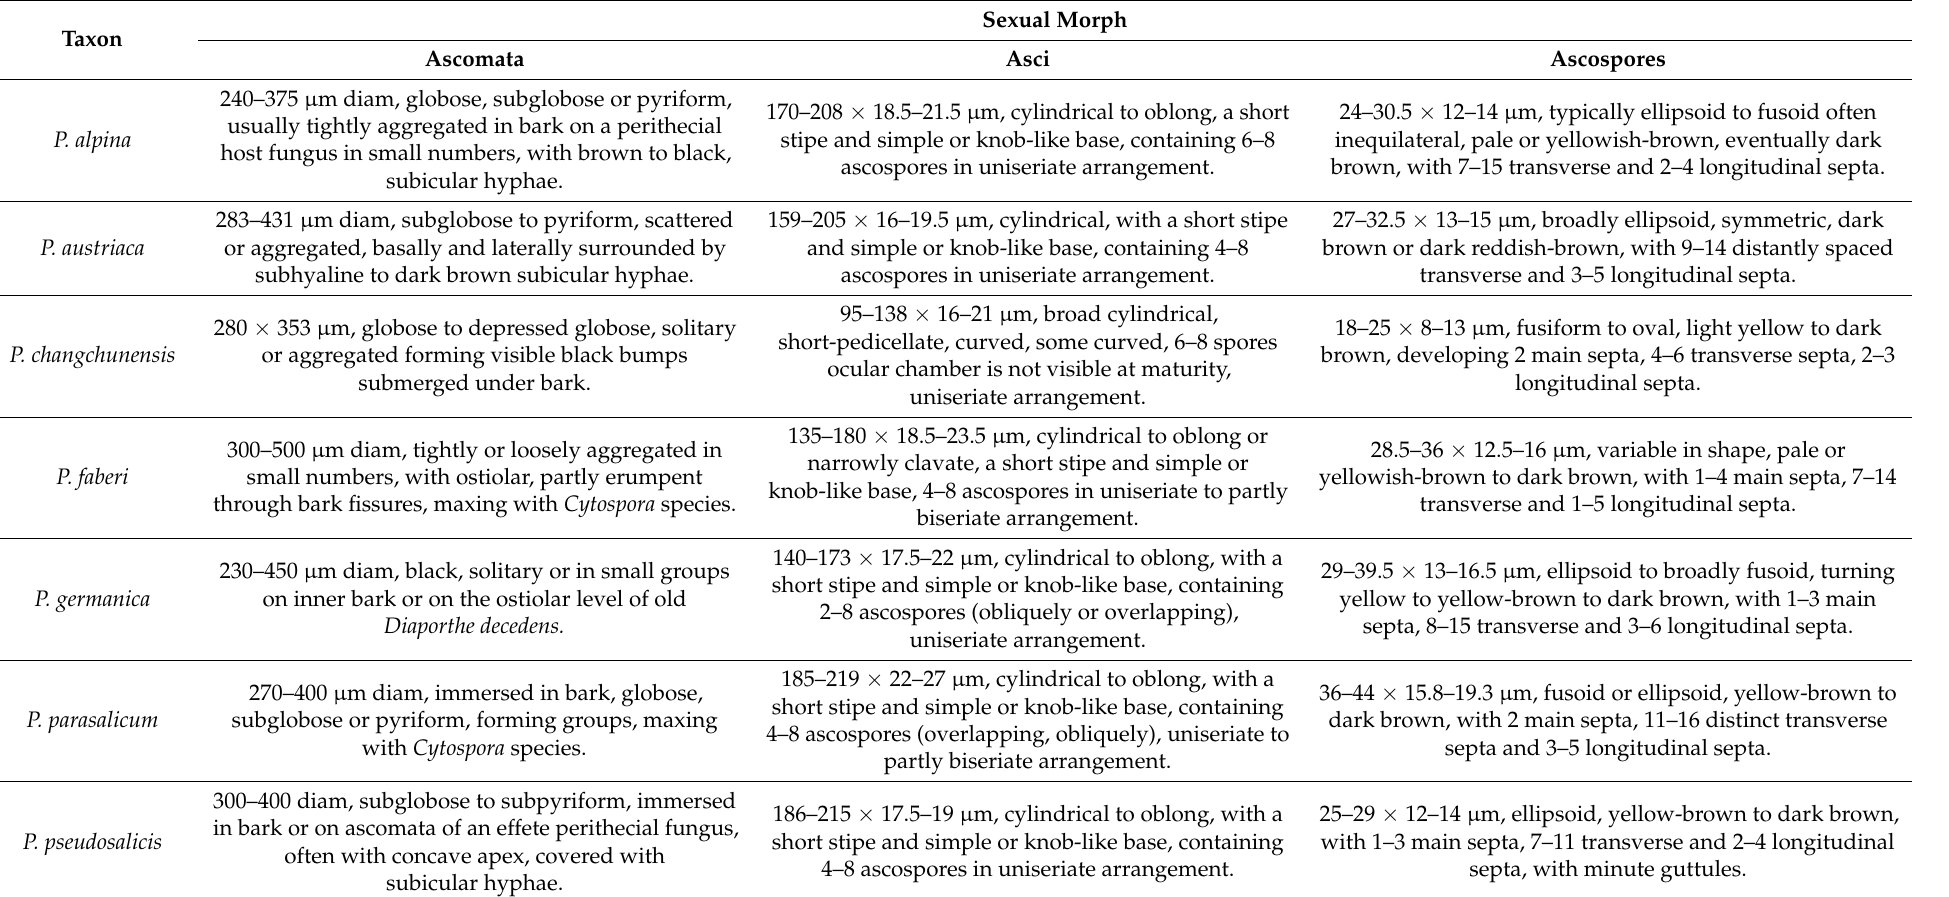
Table 3. Synopsis of sexual morph characteristics of eleven Parafenestella species with the newly introduced species in